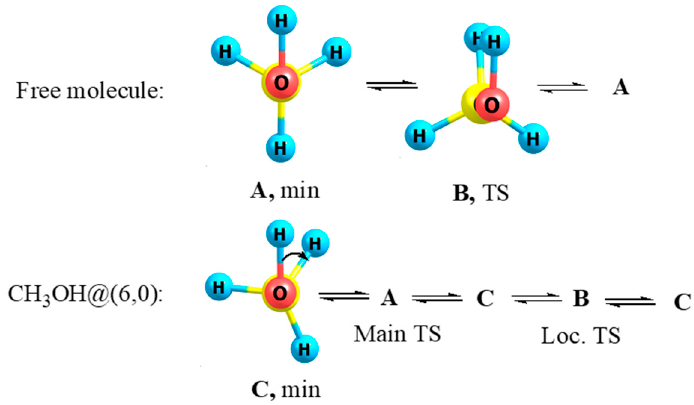
Figure 12. Conformational equilibrium of methanol. Adapted with modification [185].